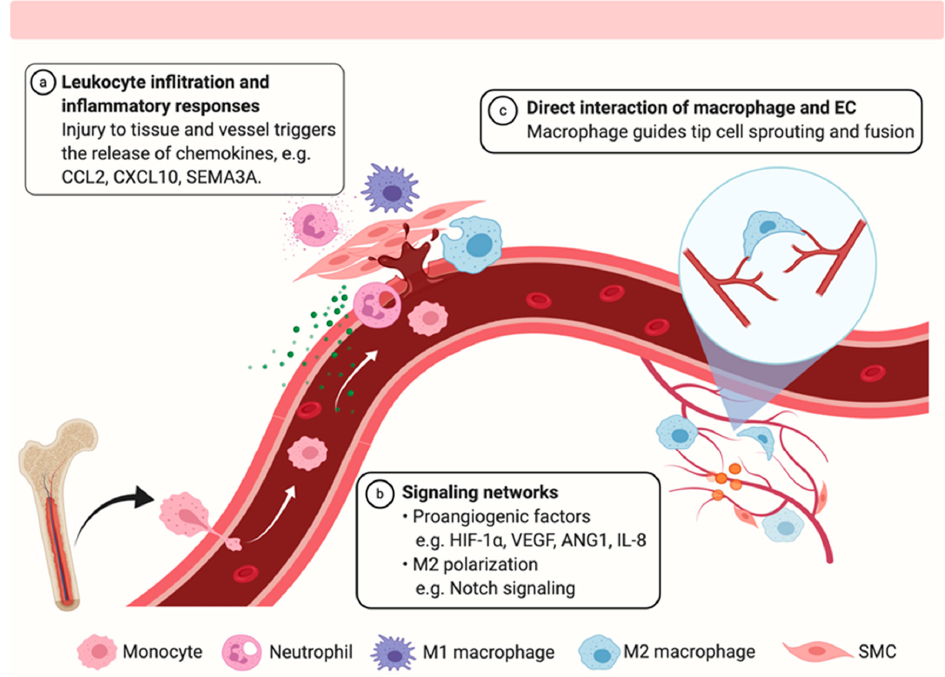
Figure 1. The role of macrophage during the vascular repair. Bone marrow-derived monocytes are recruited to the site of tissue injury in response to the chemokine gradient. Following the initial inflammatory responses, tissue-resident macrophages (TrM) and monocyte-derived macrophages (MoM) polarize to M2 phenotype for phagocytosis of necrotic cells and injured stimuli. During the proliferative phase, proangiogenic factors are induced to improve angiogenesis. Macrophages can bridge tip cells directly to guide the vessel sprouting and branching for neovascularization. The diagram is created with BioRender.com.